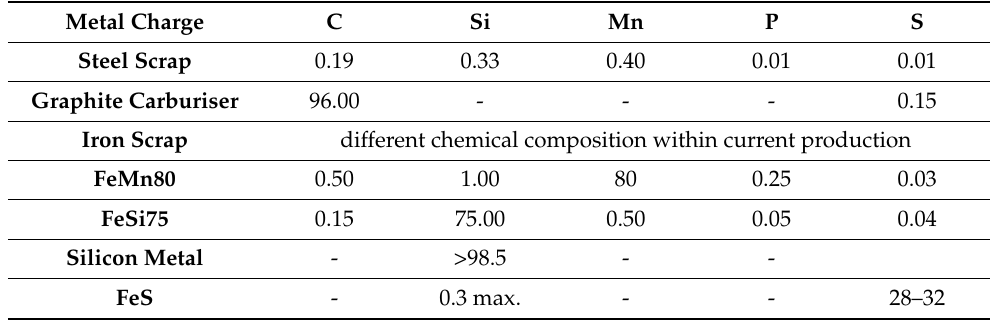
Table 2. Chemical compositions of charge materials (% mass).